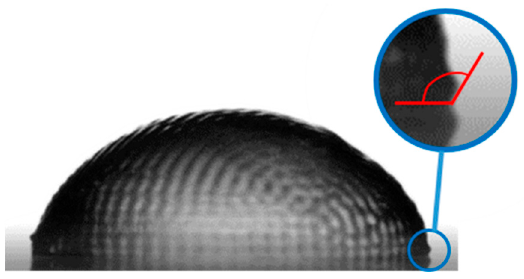
Figure 10. Surface waves on a 20 µ L droplet of deionized water as a result of CA oscillation during spreading (vibration frequency and surface acceleration are 32 kHz and ~50,000 m / s 2 respectively). The angle is shown to indicate the location of the solid surface and to demonstrate how the contact angle is accordingly measured.